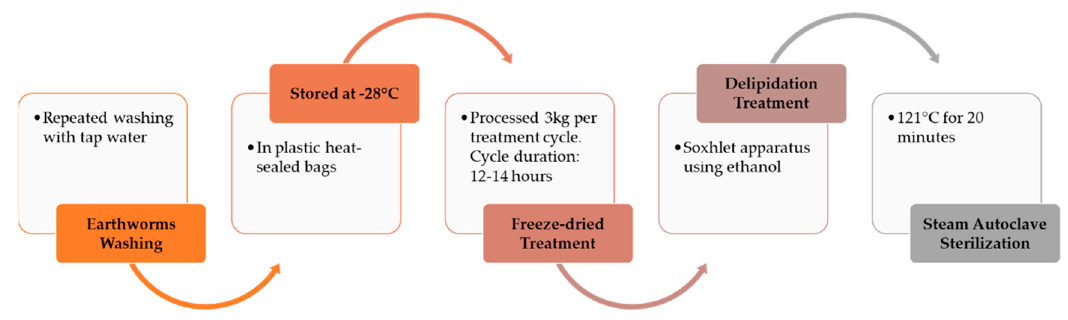
Figure 2. Steps of the transformation process from fresh earthworms to sterilized defatted earthworm meal.